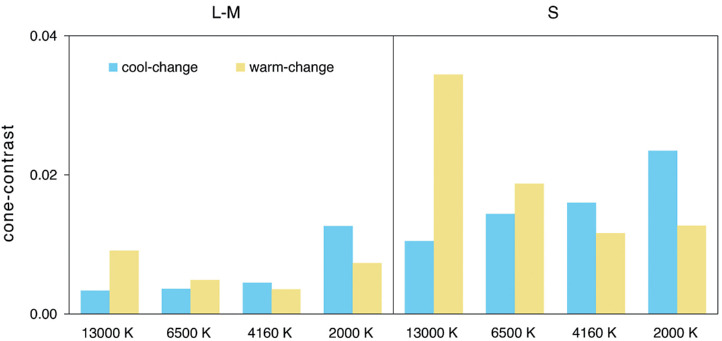
Detection thresholds of Figure 4a re-expressed in cone-contrast units for the L-M and S components of the DKL color space. Threshold values were averaged across participants (N = 22) for each test condition (cool- and warm-change) for each of the base lights and were estimated assuming the corresponding base light as the white point.